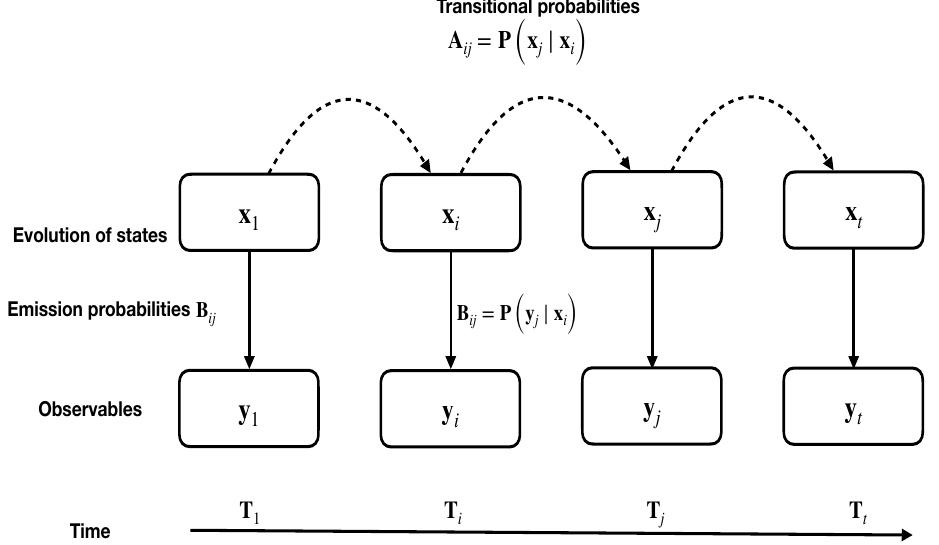
Figure 10. Hidden Markov